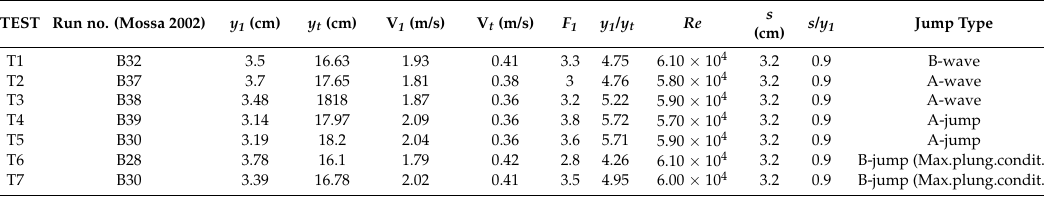
Table 1. Experimental parameters of the analysed hydraulic jumps.